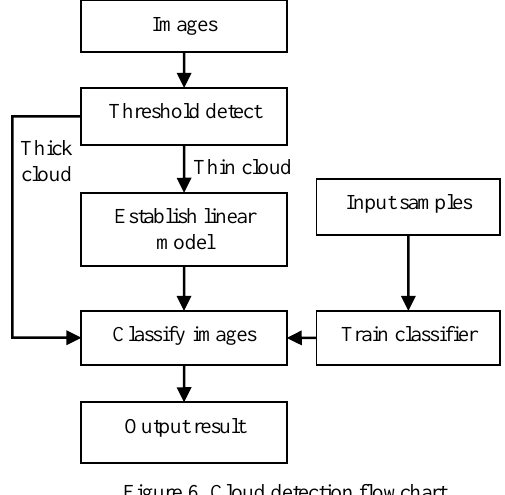
Figure 6. Cloud detection flowchart